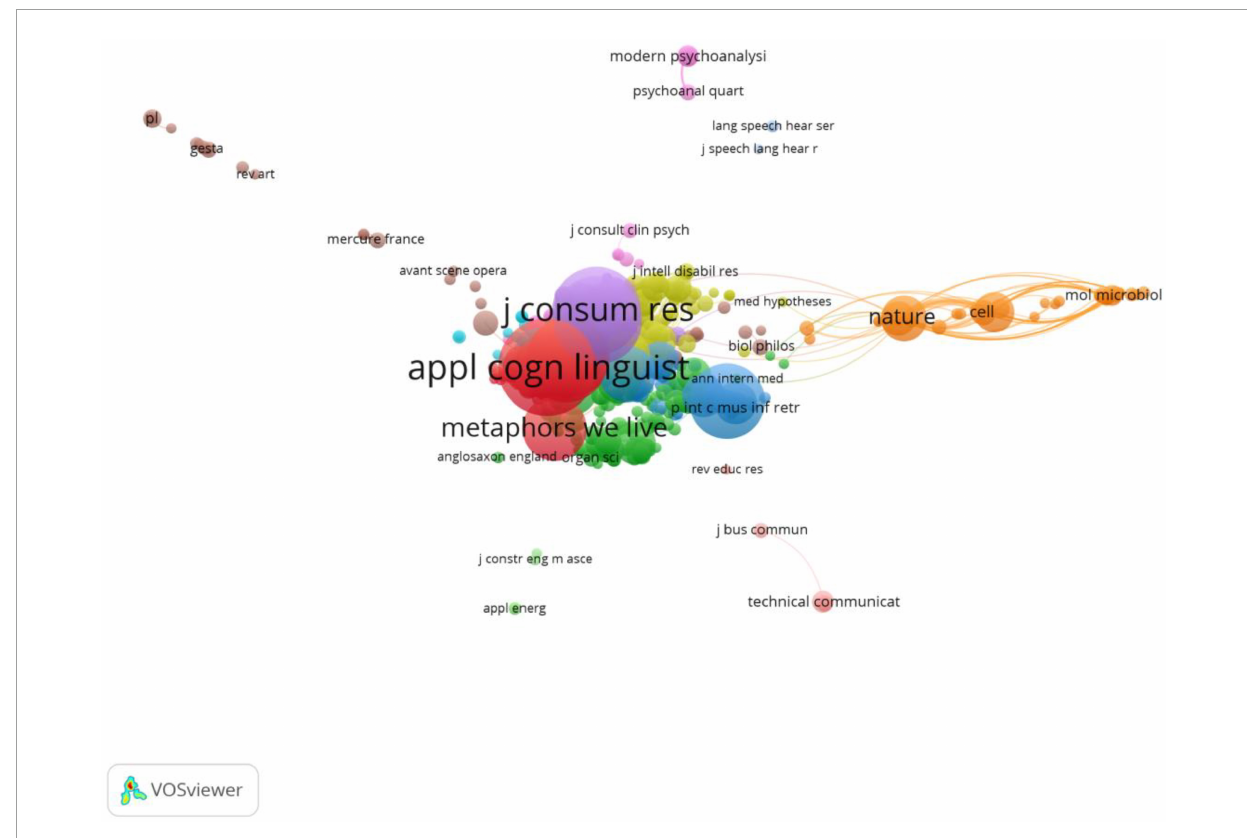
FIGURE5 Co-citation Analysis of Cited Sources (min number of citations of a source = 3; visualization by weight of citations).